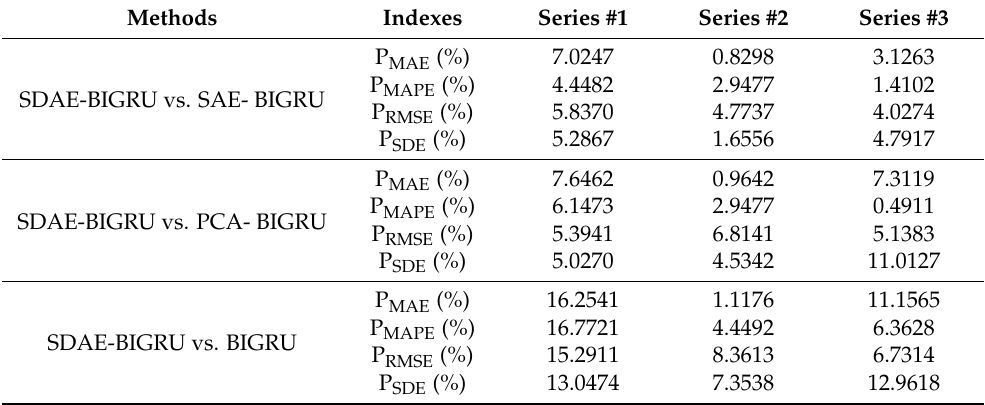
Table 1. The promoting percentages of the SDAE-BIGRU by the